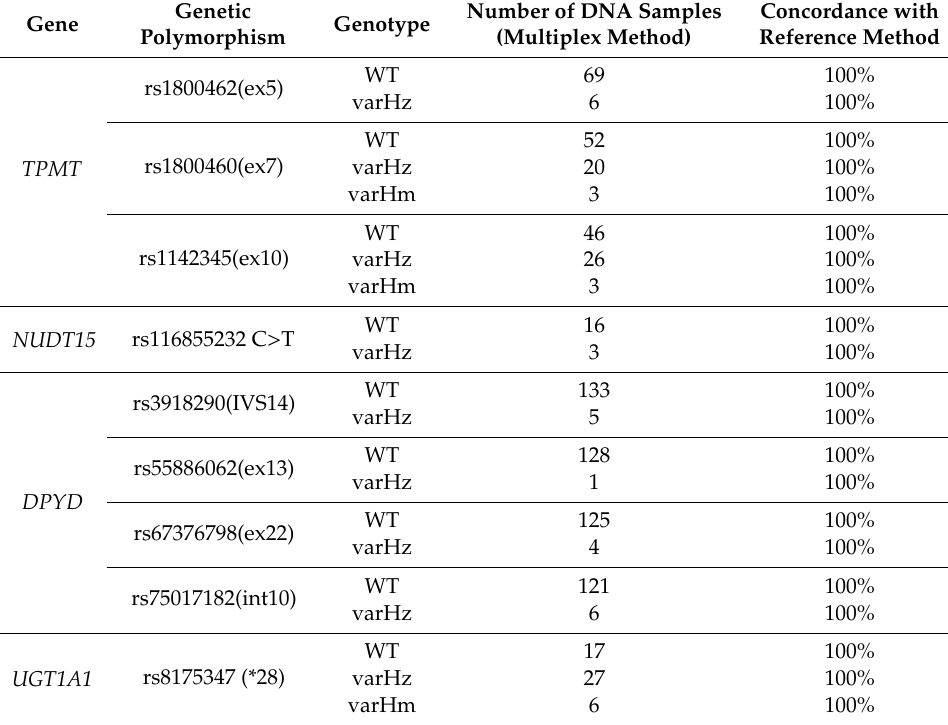
Figure 2. Representative graphical results of the migration of fragments according to genotype. TPMT rs1800460 illustrated results of allelic discrimination for a single-nucleotide polymorphism. UGT1A1 illustrated results of allelic discrimination for a polymorphism based on a nucleotide repetition. The red peak corresponds to the size of the internal standard. The green peak corresponds to the fluorescence of the HEX probe (wild type), and the blue peak corresponds to the fluorescence of the FAM probe (variant). Table 2. Accuracy of the